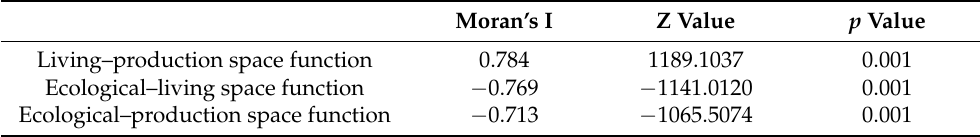
Table 7. The directional index of production–living–ecological space functions action.